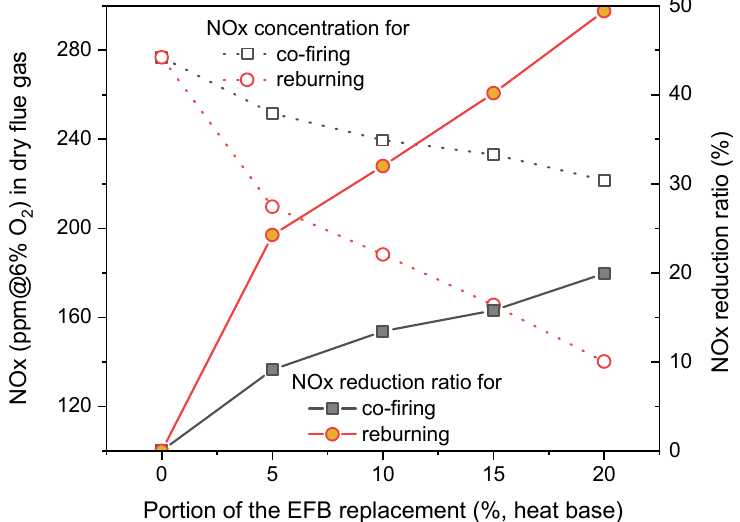
Figure 6. NOx emission and degree of NOx reduction for various EFB cofiring and reburning ratios.